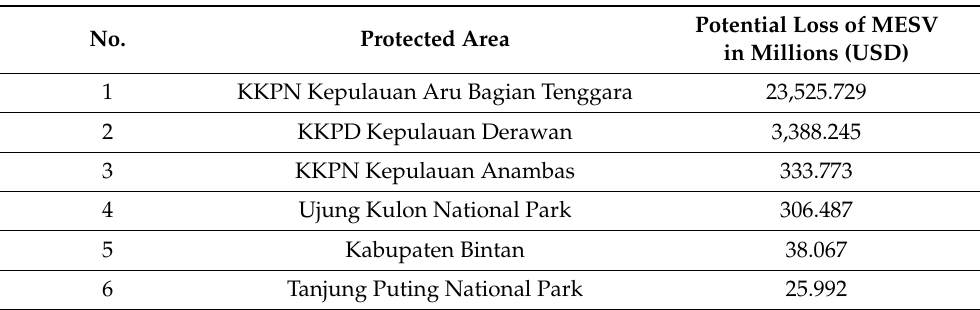
Table 3. Potential loss of marine ecosystem service value due to vessel activity expansion in 14 Indonesian MPAs.